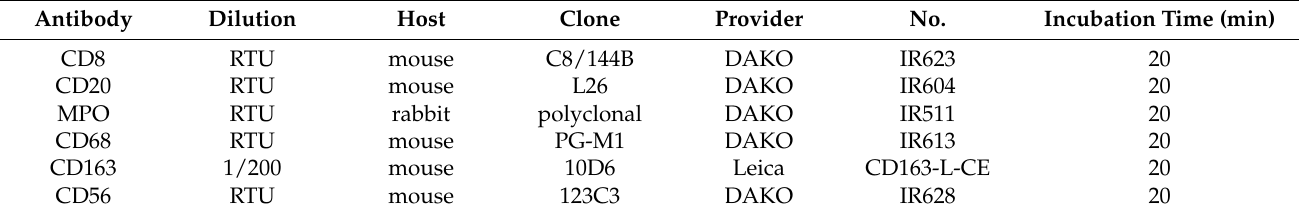
Table 3. Antibodies used for the analysis of infiltrating immune